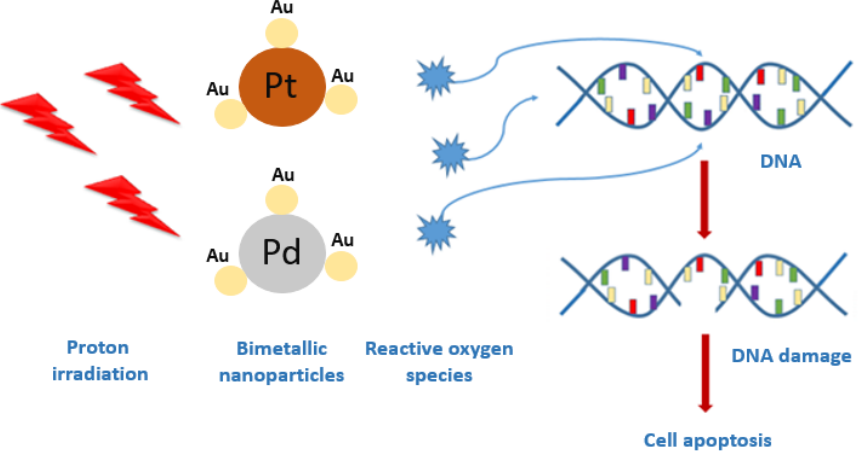
Figure 1. General scheme of the investigation procedure.